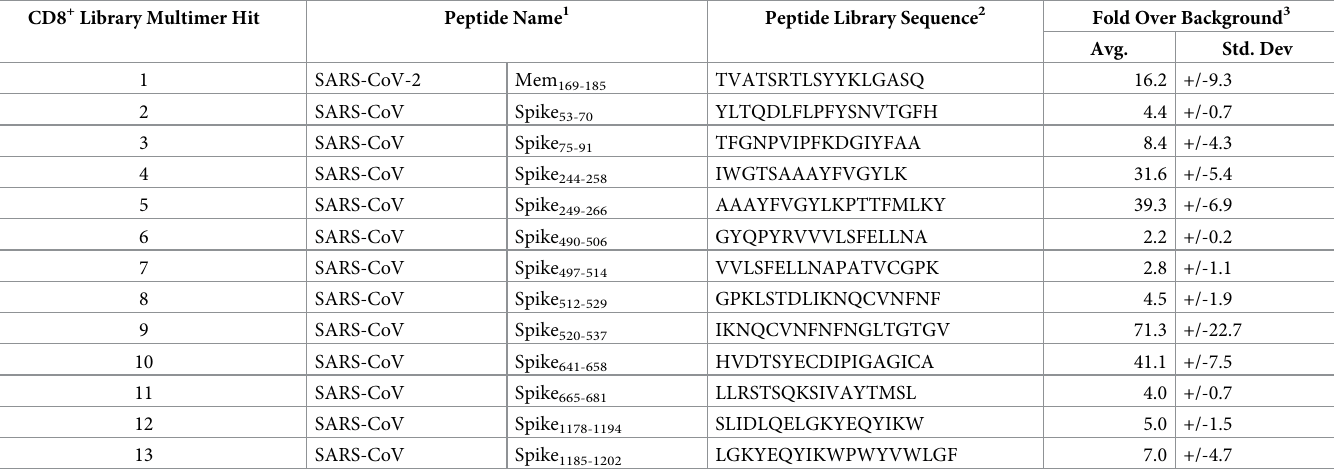
Table 1. Functional identification of SARS-CoV-2 CD8 + T cell epitopes. 1 Peptide name is based on the protein they are contained within, followed by the number of the first to the last amino acid residue of the peptide in the context of the full protein. Sequences contained within the "spike" peptide library correspond with SARS-CoV spike. 2 Exact amino acid residues of peptide used to stimulate splenocytes. 3 Average fold over background IFN- γ + CD8 + T cells stimulated with listed peptides. Background is defined as the frequency of IFN- γ + CD8 + T cells in a well stimulated with vehicle control. The average and standard deviation are from three independent